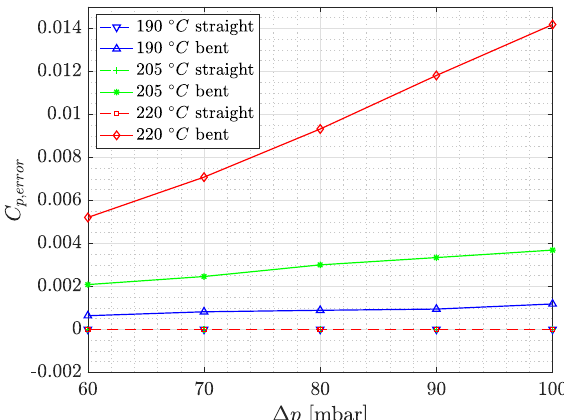
Figure 3. C p , error against the pressure difference, ∆ p , for a straight and bent pressure tap for different printing temperatures.